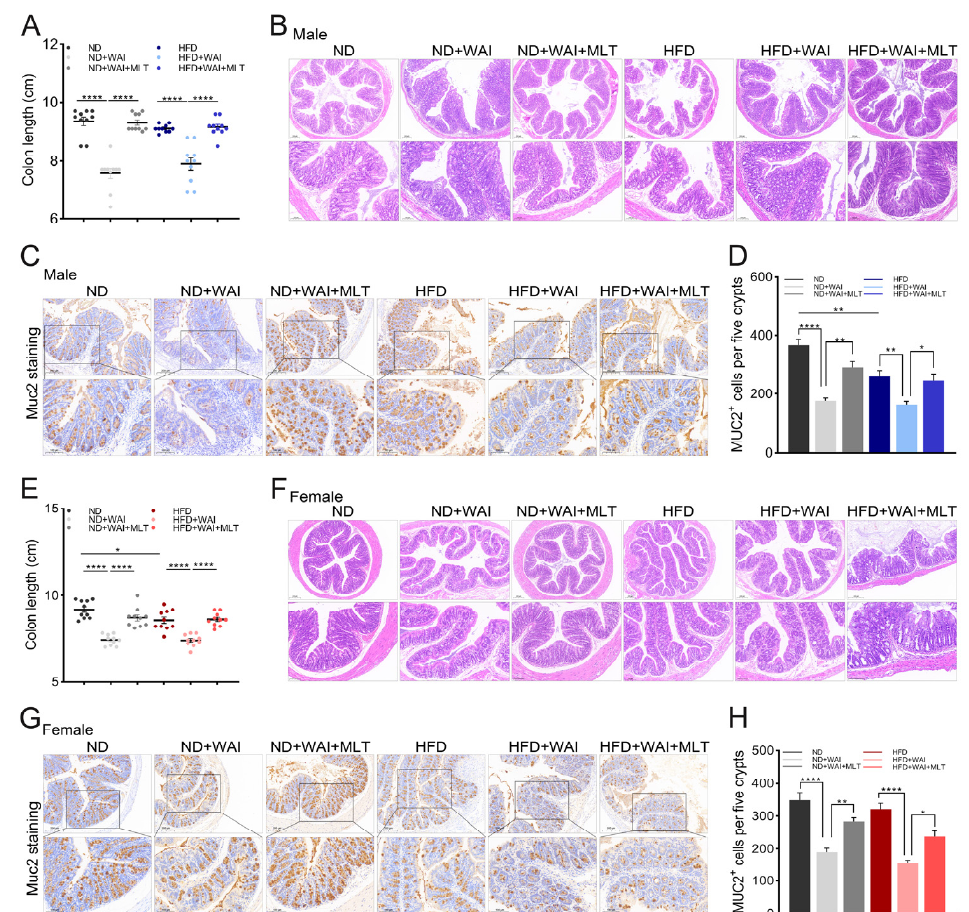
Figure 4. MLT alleviates WAI-induced colon injuries. ( A ) The length of colon tissues from male mice in the six groups. ( B ) Representative H&E staining of colon tissues from male mice (top: 5 × magnification; bottom: 10 × magnification). ( C ) Representative immunohistochemistry images showing the expression of Muc2 + in colon tissues from male mice (top: 5 × magnification; bottom: 10 × magnification). ( D ) The number of Muc2 + cells of male mice per image was quantified. ( E ) The length of colon tissues from female mice in the six groups. ( F ) Representative H&E staining of colon tissues from female mice (top: 5 × magnification; bottom: 10 × magnification). ( G ) Representative immunohistochemistry images showing the expression of Muc2 + in colon tissues from female mice (top: 5 × magnification; bottom: 10 × magnification). ( H ) The number of Muc2 + cells in female mice per image was quantified. The results are shown as the mean ± SEM, * p < 0.05, ** p < 0.01, **** p < 0.0001 between the two cohorts (5 views per group). (MLT, melatonin; WAI, whole abdominal irradiation; H&E, hematoxylin and eosin; SEM, standard error of mean).